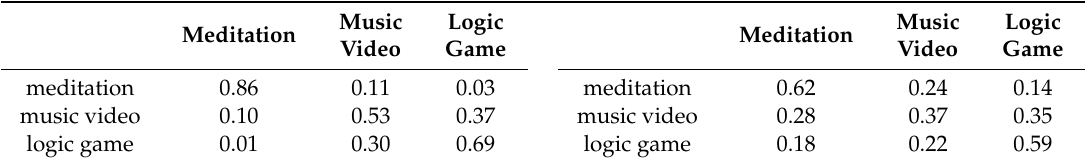
Table 18. Normalized confusion matrix for SVM classifier with RBF kernel, C = 10, γ = 10, and the welch32 feature extraction scheme (left). Normalized confusion matrix for SVM classifier with RBF kernel, C = 1, γ = 0.1, and the ar16 feature extraction scheme (right).